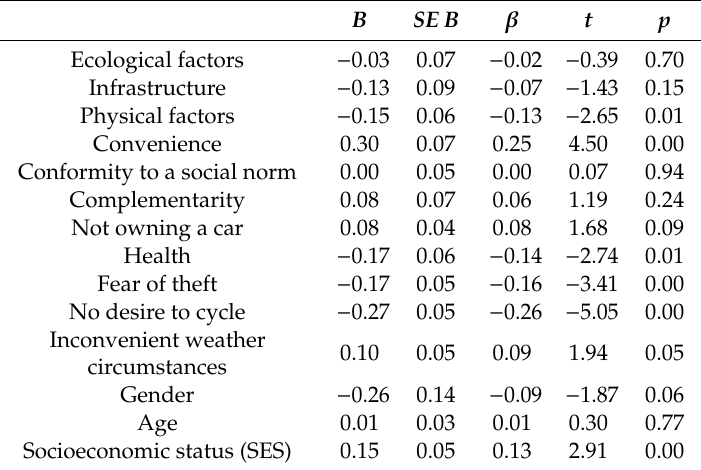
Table 2. Determinants of cycling